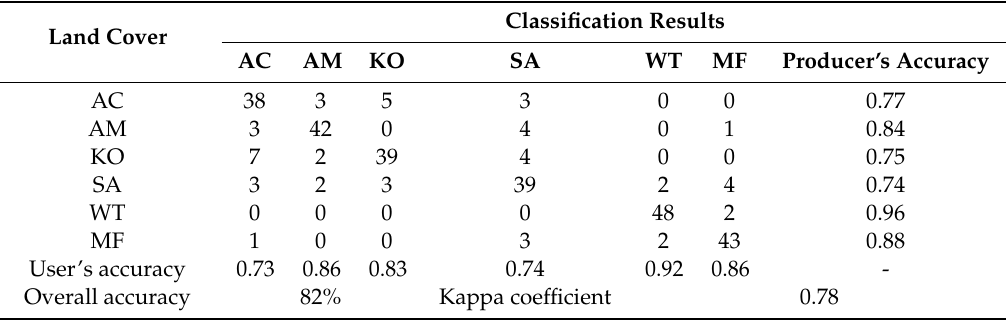
Table 3. Confusion matrix of the top nine months classification, including overall accuracy, producer’s accuracy, user’s accuracy, and Kappa coe ffi cient for all classes. KO: Kandelia Obovata , AC: Aegiceras corniculatum , AM: Avicennia marina , SA: Spartina alterniflora , WT: water, and MF: